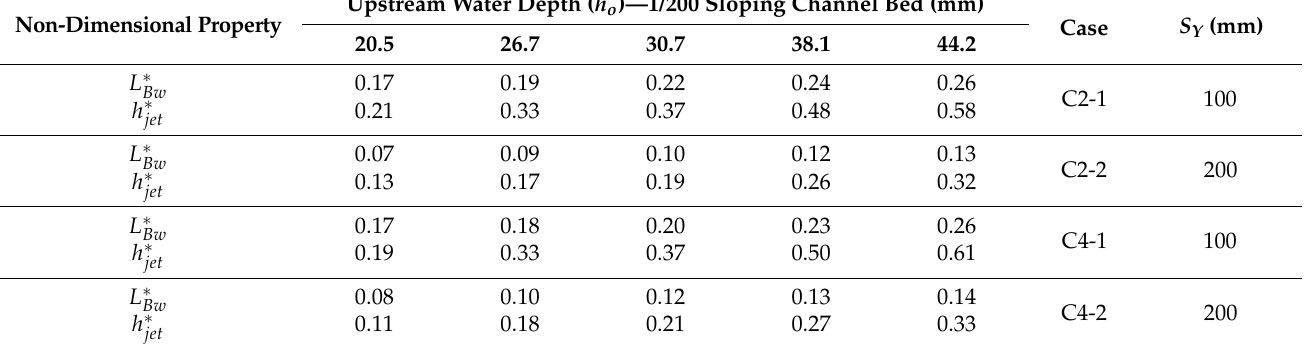
Table 5. Non-dimensional values for surface bow-wave length ( L ∗ to the spacing of S Y